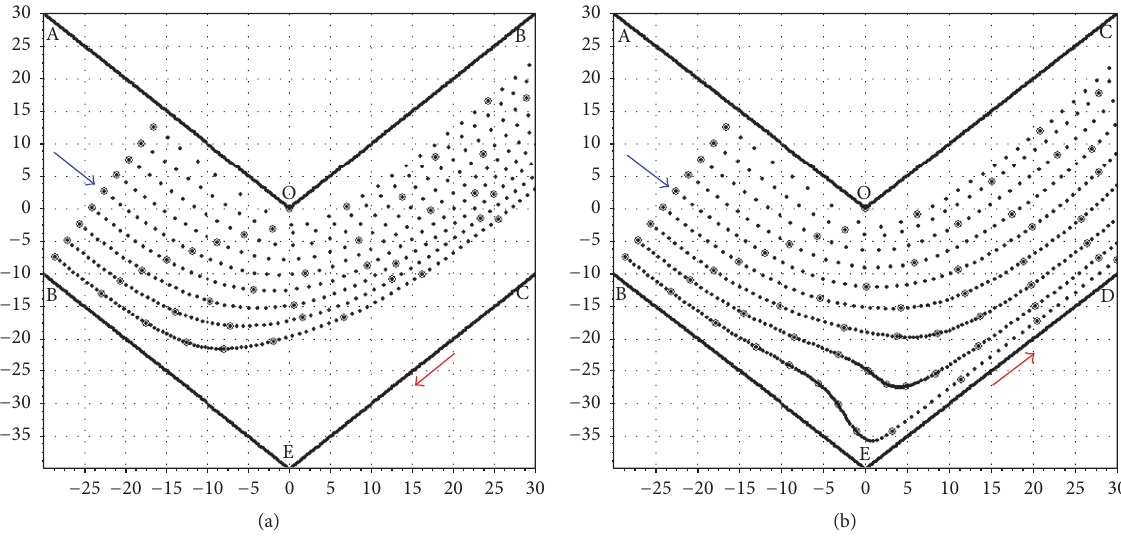
Figure 5: CFD-derived flow lines for a Segal die with channel intersection angles ∠ (AOC) = 2 𝜃 = 105 ∘ , where outlet die wall ED moves upstream towards the punching direction with velocity 𝑉 𝑤 = −𝑈 0 (a), and outlet die wall ED moves downstream stream-wise with velocity = +𝑈 𝑈 𝑉 𝑤 0 (b), where 0 is punching velocity and the dimensional transition times are 1172ms = 1.172 s (a) and 1831ms = 1.831 s